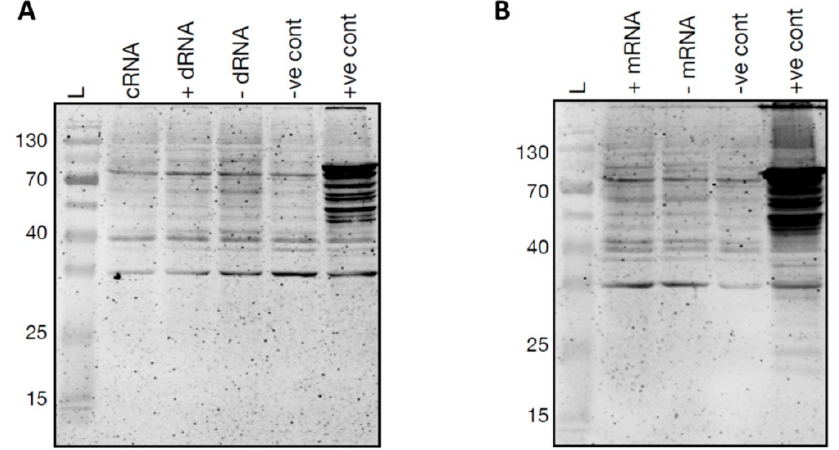
Figure 5. In vitro translation of PSTVd RG1 . In vitro translation of ( A ) circular RNA (cRNA), dimeric (+) PSTVd RNA (+ dRNA), dimeric (-) PSTVd RNA (-dRNA) and ( B ) monomeric (+) PSTVd RNA (+ mRNA), monomeric (-) PSTVd RNA (- mRNA). A reaction mixture without any template RNA was used as negative control ( - ve cont), and luciferase control RNA was used as the positive control ( + ve cont).